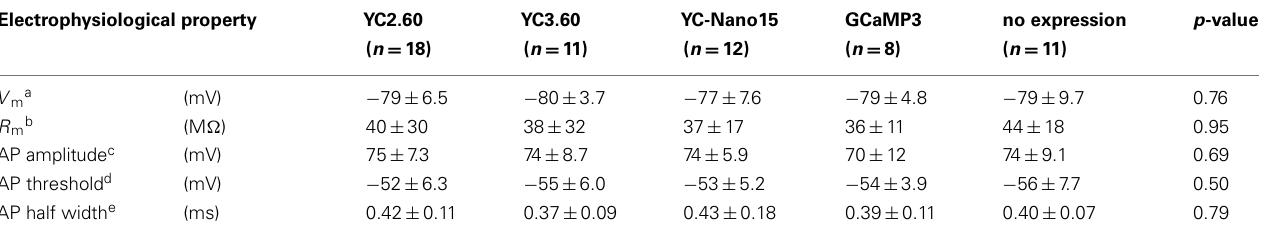
Table 3 | Electrophysiological properties of cerebellar Purkinje cells expressing GECIs.